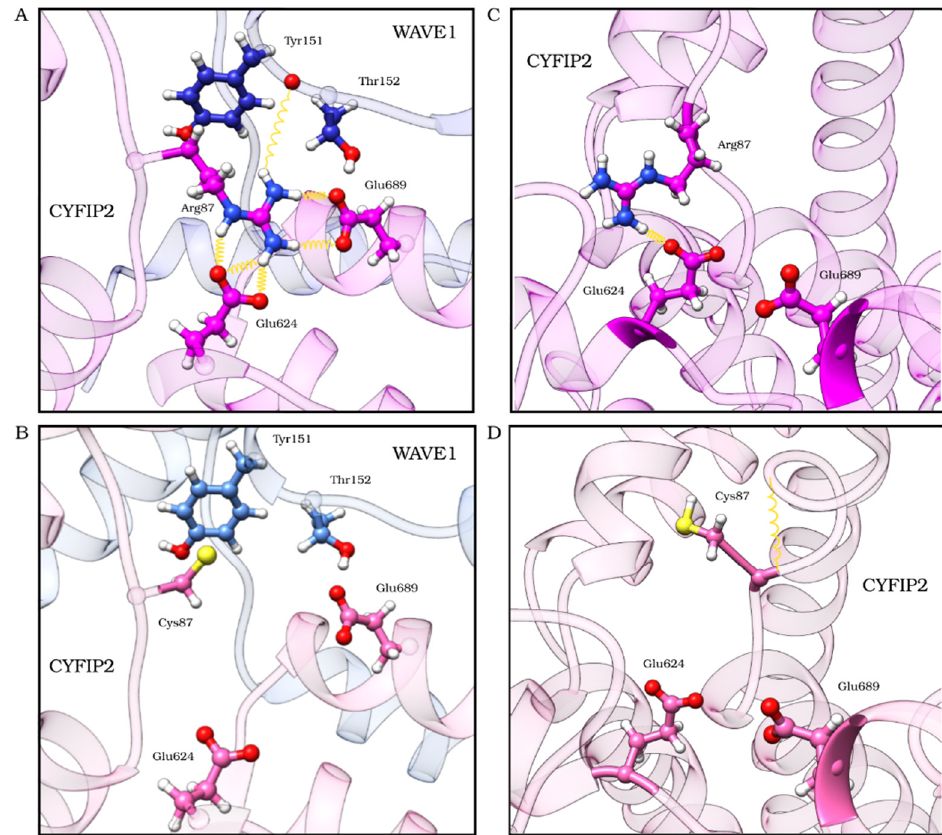
Figure 6. Residues that interact through hydrogen bonds with CYFIP2 R87 within the complex ( A ) and outside the complex ( C ) and how the C87 mutant loses these interactions within the complex ( B ) and outside the complex ( D ), causing the loosening of the loop and resulting in a structural change in the protein during our simulation. CYFIP2 residues are represented in magenta, and WAVE1 residues are represented in blue. Structures of the first cluster centroid are from the first replicate. Yellow springs represent hydrogen bonds.